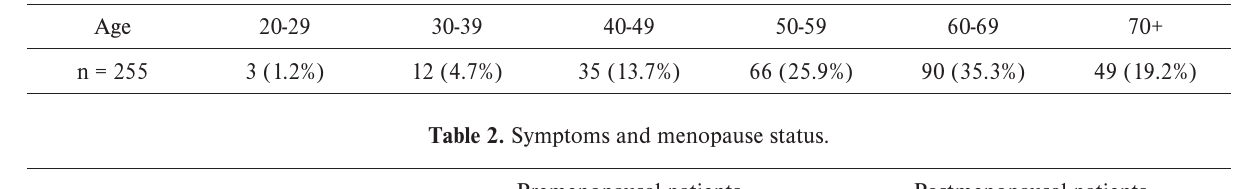
Table 1. Age distribution.